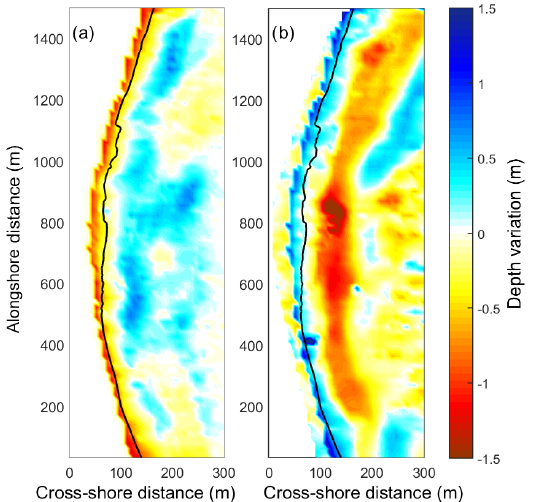
Figure 8. Depth variation estimated from XBeach and from mea- surements. (a) Bottom variation during the storm group (17 March to 8 April). (b) Bottom variation for the period of calms (8 April to 12